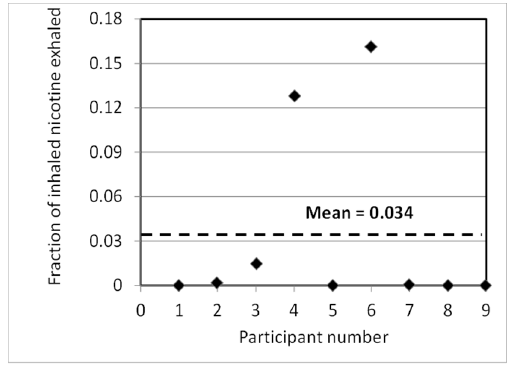
Figure 4. Fraction of inhaled nicotine that is exhaled [27].